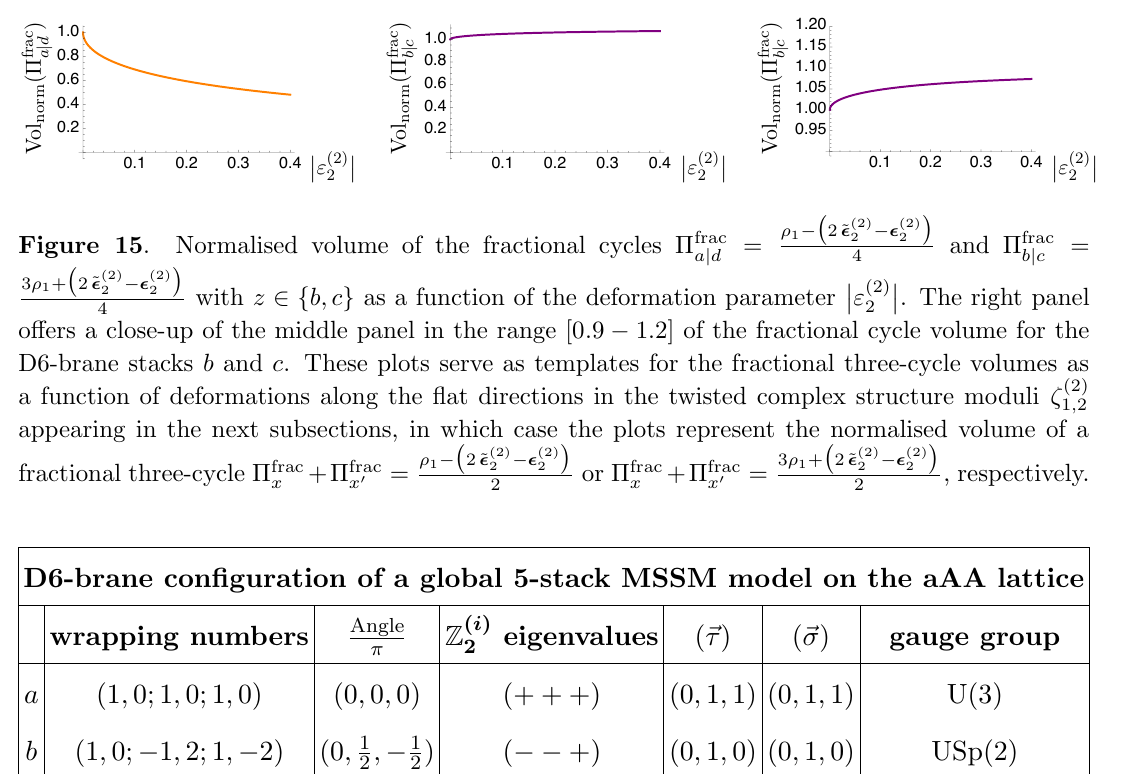
Figure 15 . Normalised volume of the fractional cycles (cid:5) frac